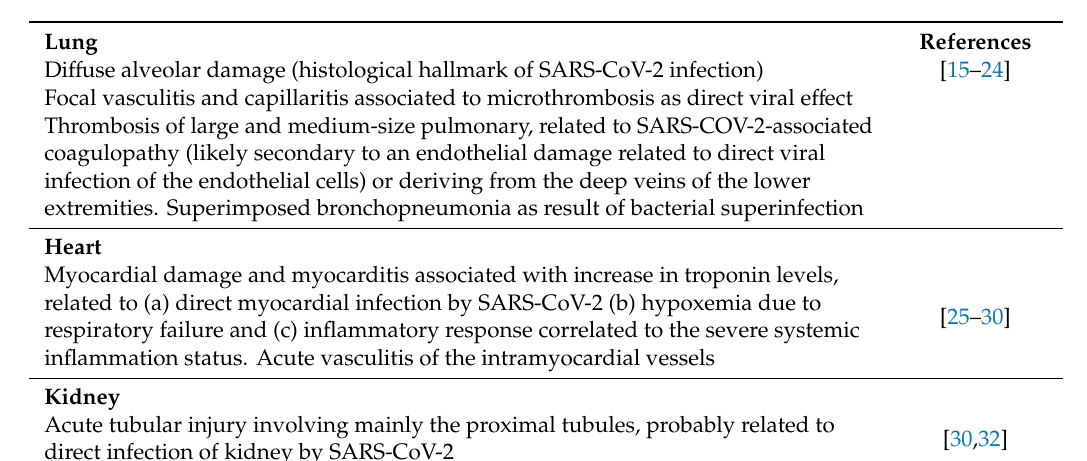
Table 2. Most important histological lesions observed during autopsy of patients who died from SARS-CoV-2